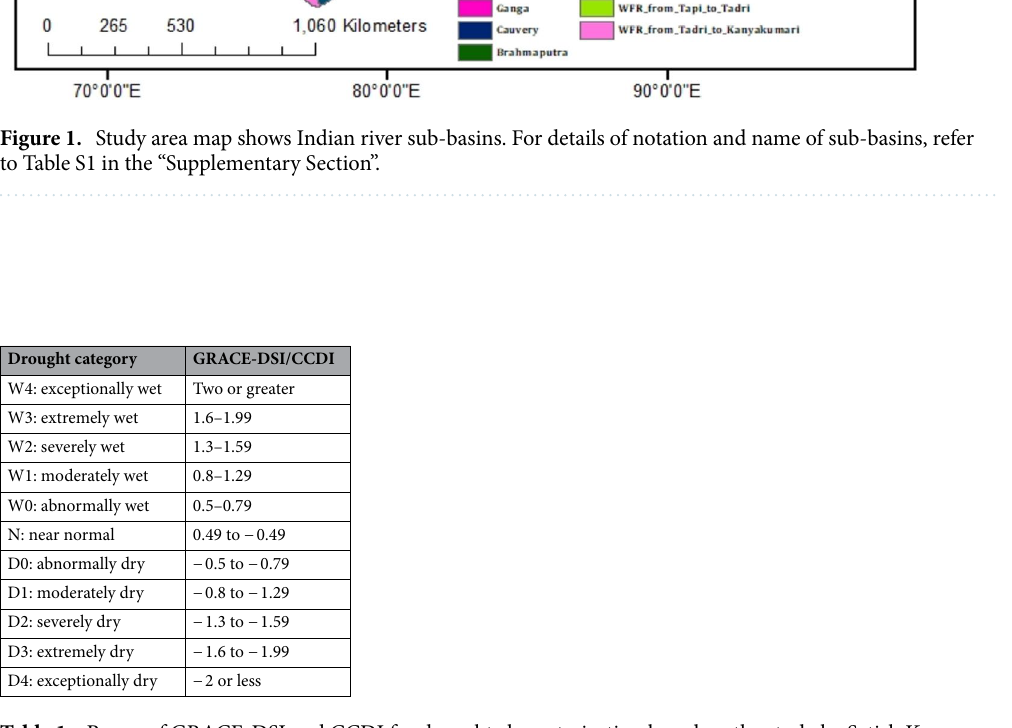
Table 1. Range of GRACE-DSI and CCDI for drought characterization based on the study by Satish Kumar et al. 21 . A negative value of the drought index represents the dry condition, while a positive value of the drought index represents the wet